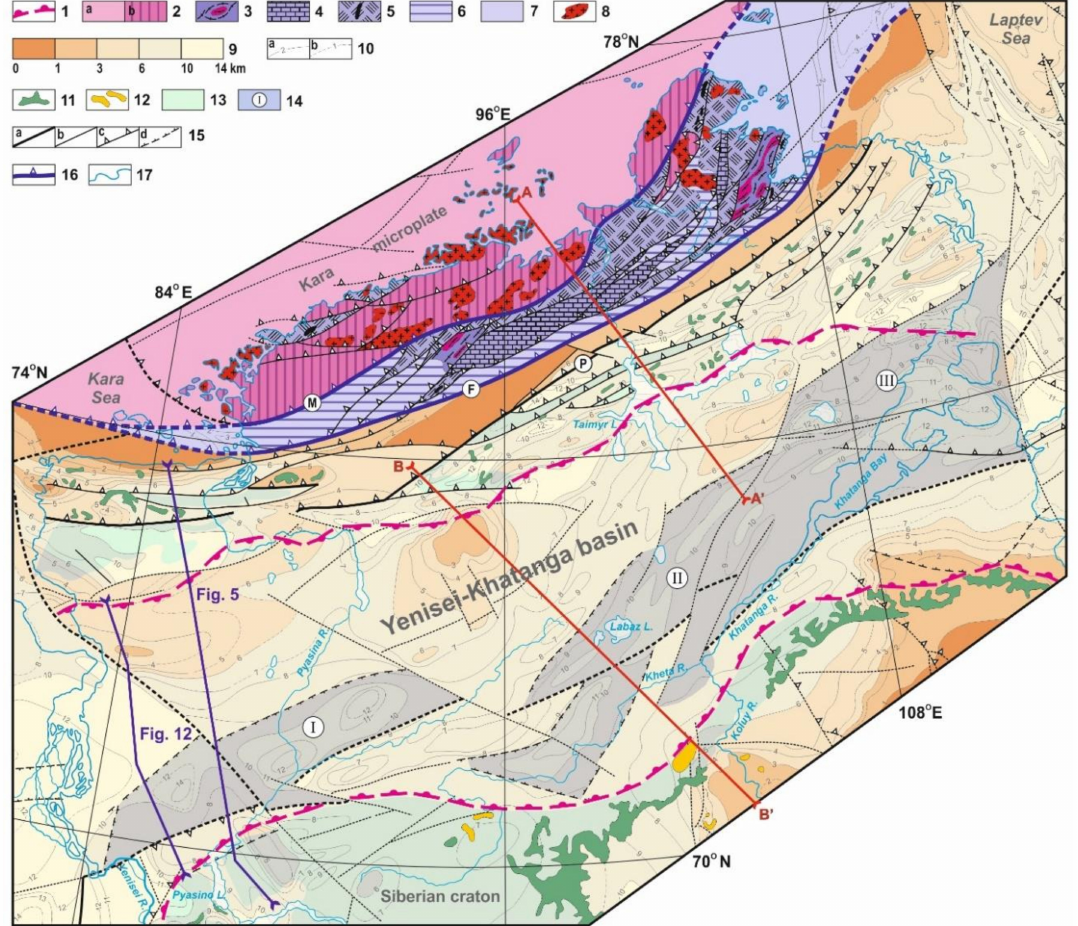
Figure 2. Tectonic map of the north–western part of the Siberian craton, the Taimyr folded area and the Yenisei-Khatanga basin. Composed using References [5,6] with additions by the authors. 1—boundary of the Yenisei-Khatanga basin along outcrops of Early Jurassic and younger rocks; 2—Kara microcontinent (a) including metamorphosed and deformed flyschoid passive margin sediments (NP– Є ) of the North Taimyr Zone (b); 3–7—the Central Taimyr accretionary belt: 3—gneiss complexes of cratonic terranes with 940–850 Ma granitoids; 4—terranes of carbonate shelves (MP(?)–NP); 5—island arc terranes, ophiolites and plagiogranites (750–630 Ma), and